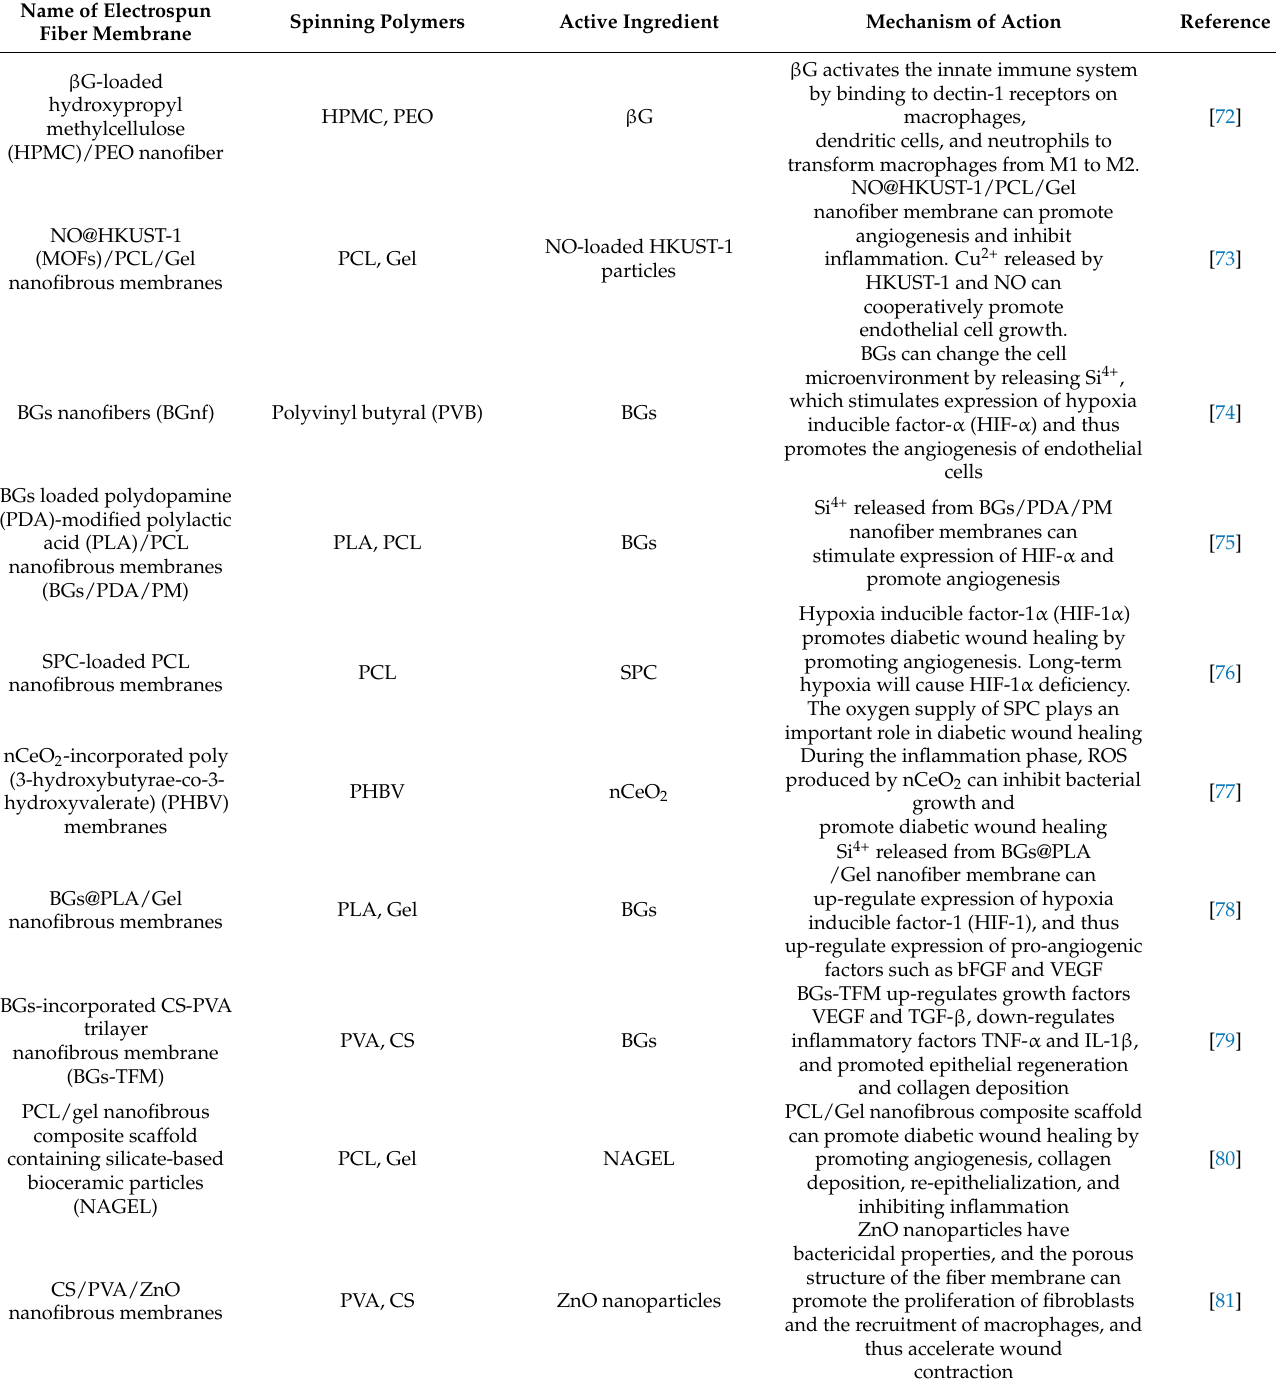
Table 1. Nanoparticle-loaded electrospun fibers in the treatment of diabetic